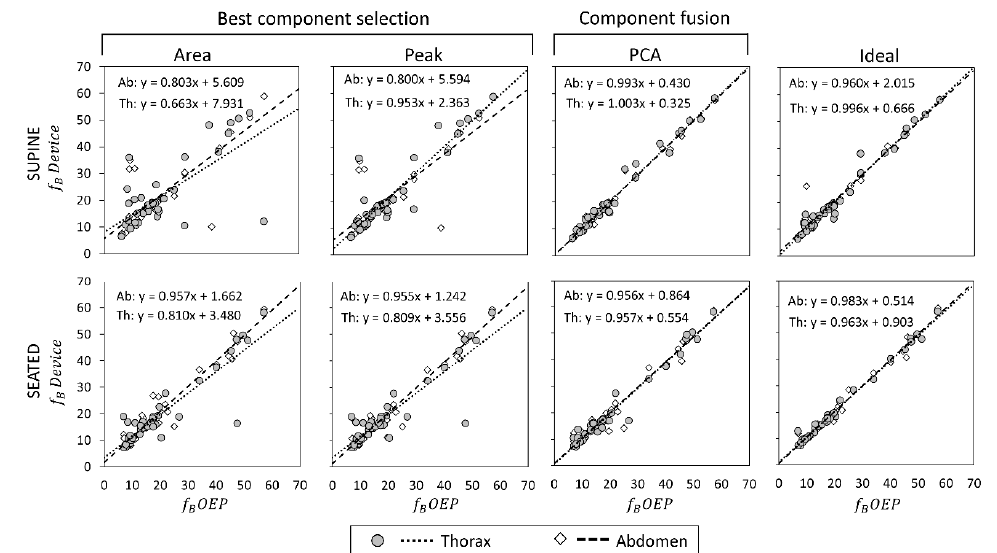
Figure 5. Comparisons of breathing frequency (f B expressed as breaths/minuteute) measurements by using the proposed device and by using Optoelectronic plethysmography (OEP) presented as regression analysis, in supine (top panels) and seated (bottom panels) positions. For what concerns f B measurements obtained with the IMU-device, three dimension-reduction methods were considered: Area, Peak and PCA-fusion. The performance obtained by using these three methods is benchmarked against that obtained with the Ideal quaternion component determined a posteriori based on the minimum estimation error. The regression line between measurements done by OEP and the proposed device is plotted, and the relative equation presented, both for the thorax and the abdomen.